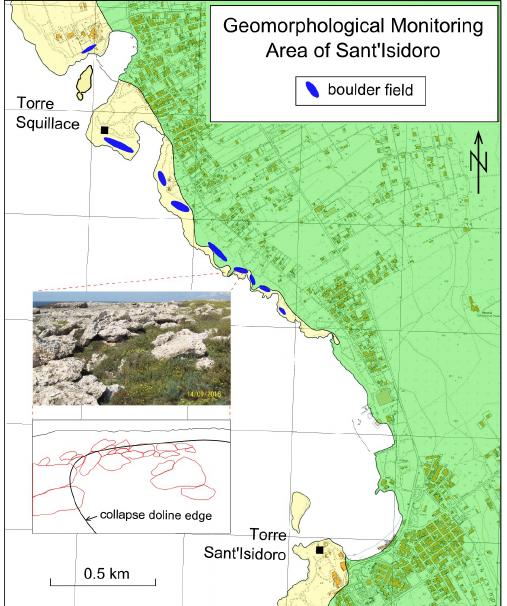
Figure A1. Geological map of the monitoring area with the location of the boulder fields (see Figure 1 for the legend); a group of imbricated boulders on a doline edge is clearly visible in the pictures.